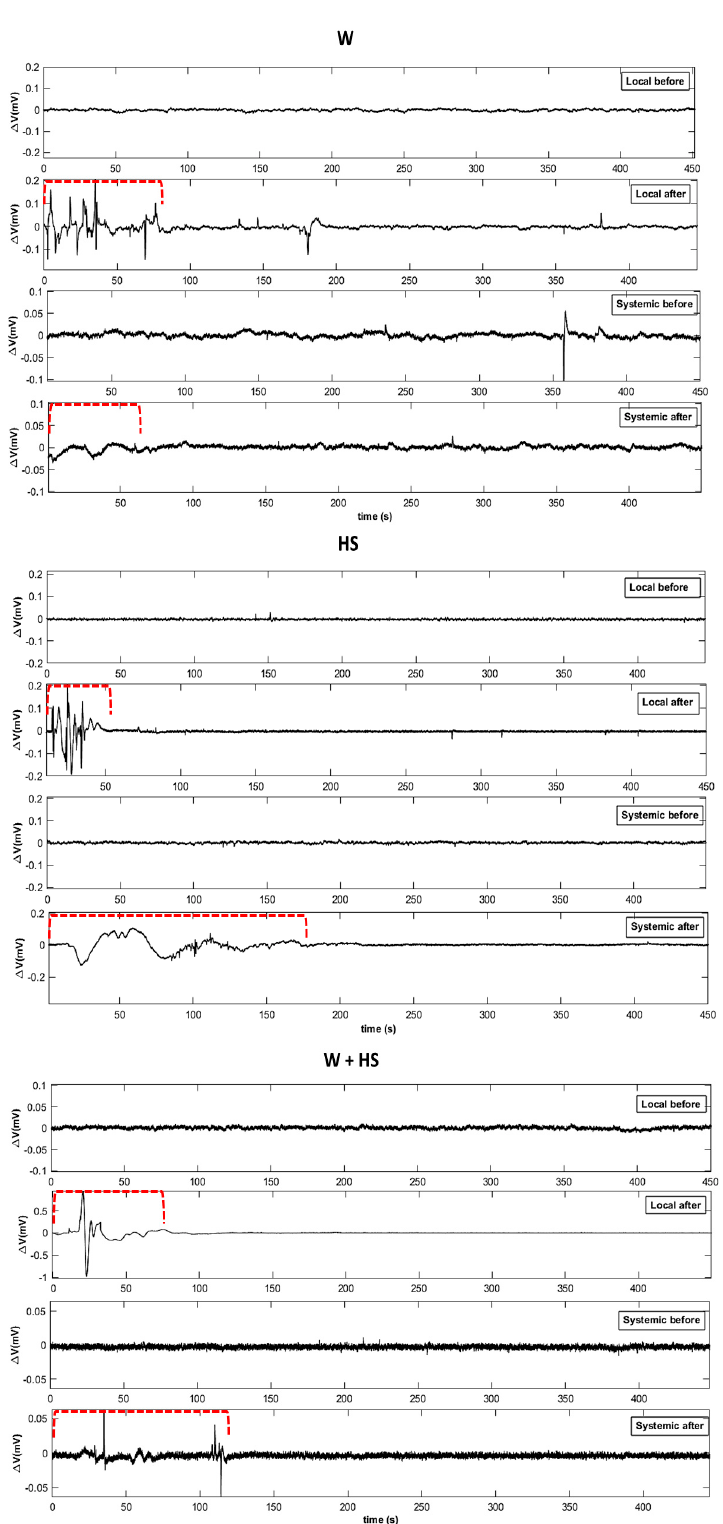
Figure 2. Original representation of the time series before and after the stimuli for wounding (W), heat shock (HS), and combined stimuli (W+HS) in local and systemic leaves. To facilitate comparison, the total length of the series (x = 1 h) was reduced to 7.5 min of measurement. The y-axis ( Δ V) was adjusted for each situation. The red dotted line indicates the moment of greatest electrome change after stimulation.